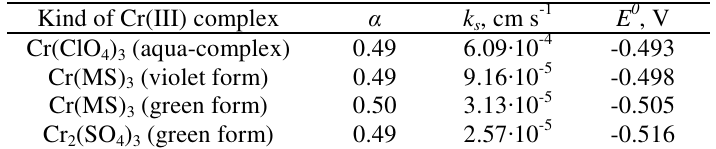
Table 1 . Kinetic and thermodynamic data for the one-electron reduction of Cr(III) complexes on Pb